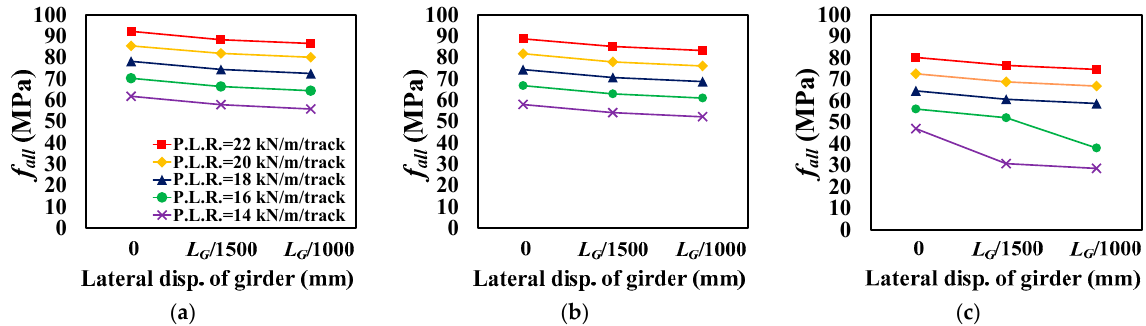
Figure 15. Effect of lateral displacement of girder ( L G = 9 m): ( a ) R = 1500 m; ( b ) R = 700 m; and ( c ) R = 300 m.